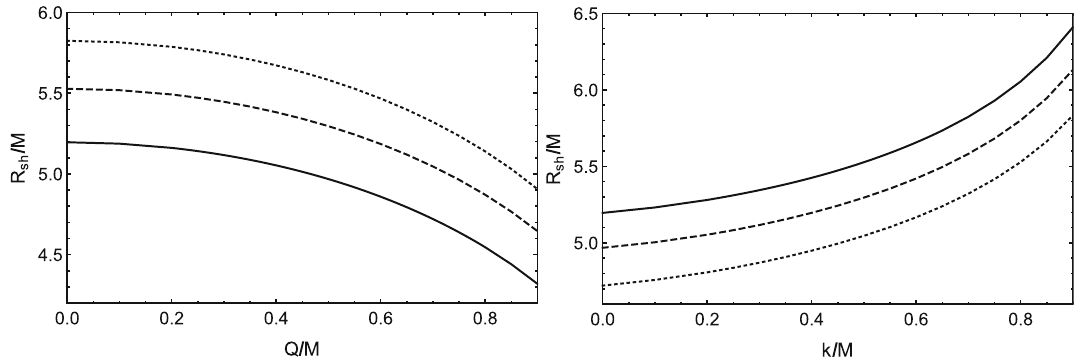
Fig. 5 The radius of the shadow as a function of charge and plasma parameter. In the left panel the solid, dashed and dotted plots correspond to k / M = 0, 0.5 and 0.7, respectively. In the right panel the solid, dashed and dotted plots correspond to Q / M = 0, 0.5, and 0.7, respectively